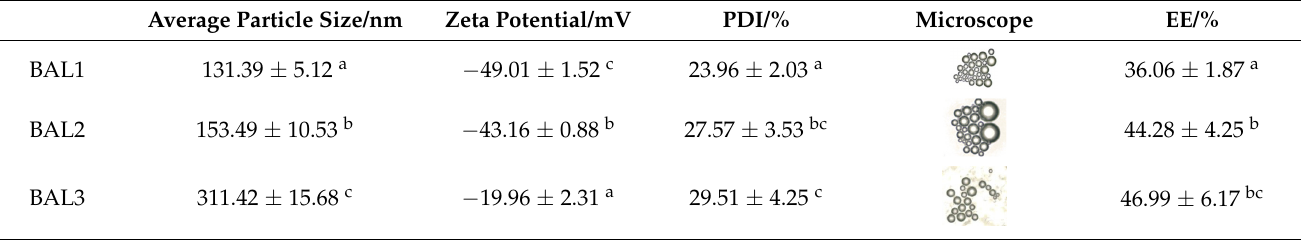
Table 1. The sizes, Zeta potentials, PDI values, EE values, and microscope pictures of the liposomes.